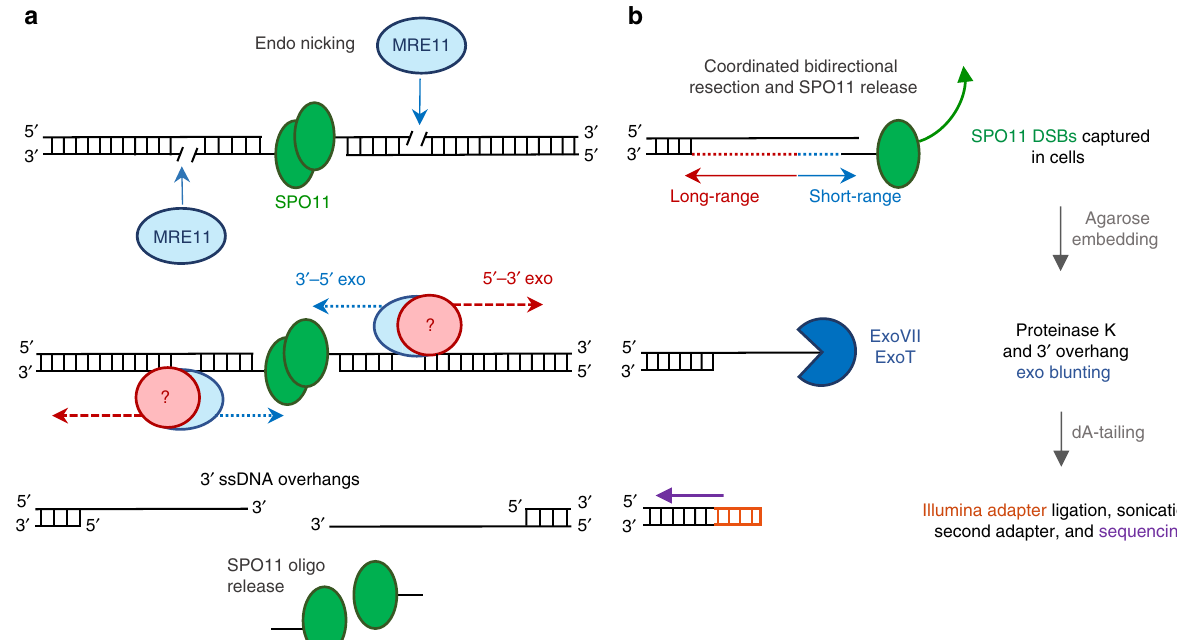
Fig. 1 SPO11 generates meiotic DSBs that are detectable by END-seq. a Illustration of meiotic break generation and processing. SPO11 induces a double- strand break (DSB) and remains covalently bound to both DNA ends. MRE11 recognizes the DSB and induces a nick on the SPO11-bound strand. Tightly coordinated short-range 3 ′ − 5 ′ resection by MRE11 and long-range 5 ′ − 3 ′ resection by an unknown nuclease generates 3 ′ overhangs for homology search. MRE11 activity releases SPO11 bound to short oligonucleotides (SPO11 oligos). b Brief schematic of END-seq detection of SPO11 DSBs (only one side of the DSB is shown for simplicity). In vivo processing of SPO11 by coordinated bidirectional resection removes covalently bound SPO11 and produces a 3 ′ overhang present at the time of END-seq preparation and agarose cell embedding. Initial END-seq processing degrades all proteins by proteinase K and blunts ssDNA overhangs by in vitro nuclease digestion (dark blue). Once fully blunted and dA-tailed, the DNA end is ligated to a biotinylated Illumina sequencing adapter (orange), sheared, and streptavidin captured. A second Illumina adapter is ligated at the other end of the sonicated fragment after end repair and